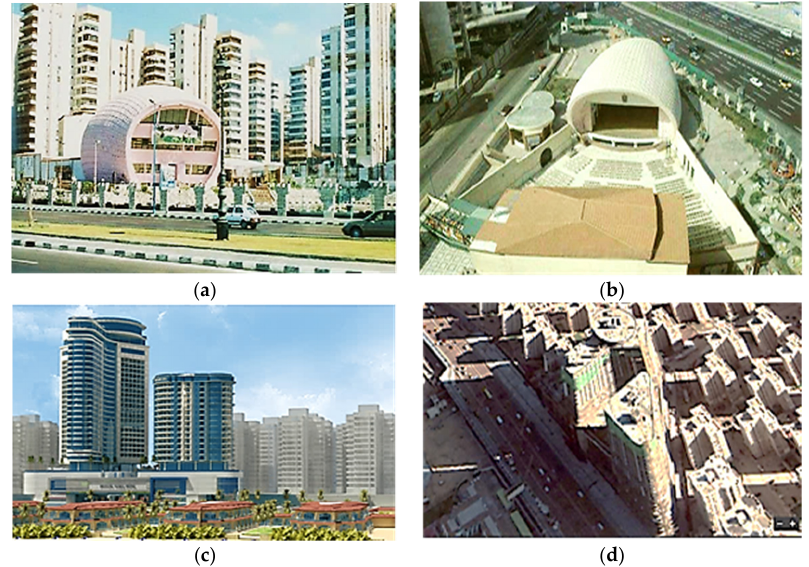
Figure 2. ( a ) Al Salam Theatre in its original context. Source: [49]. ( b ) Al Salam Theatre site plan view. Source: [49]. ( c ) A 3D view of the new hotel project that replaced the theatre. Source: [50]. ( d ) A Google Earth view showing the new unfinished hotel project replacing the theatre site plan. Source: Google Earth.